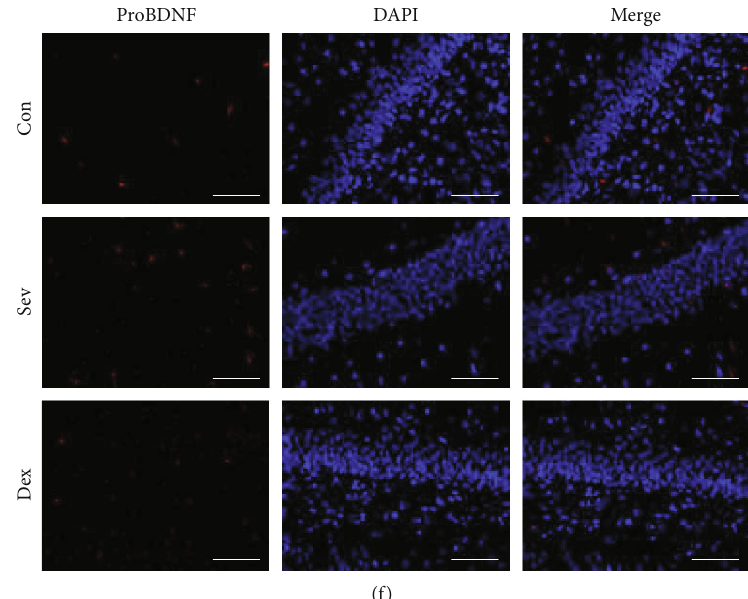
Figure 4: Dexmedetomidine could decrease the level of proBDNF and restore the ratio of proBDNF/mBDNF and alleviates activation of the proBDNF-P75NRT-RHOA pathway after sevo fl urane. (a) Western blot band. (b) ProBDNF/mBDNF. (c – e) Bar graph of Western blot. (f) Immuno fl uorescence of proBDNF ( scalebar = 50 μ m ). ∗ Compare with the control group, P < 0 : 05 ; # Compared with the Sev group, P < 0 : 05